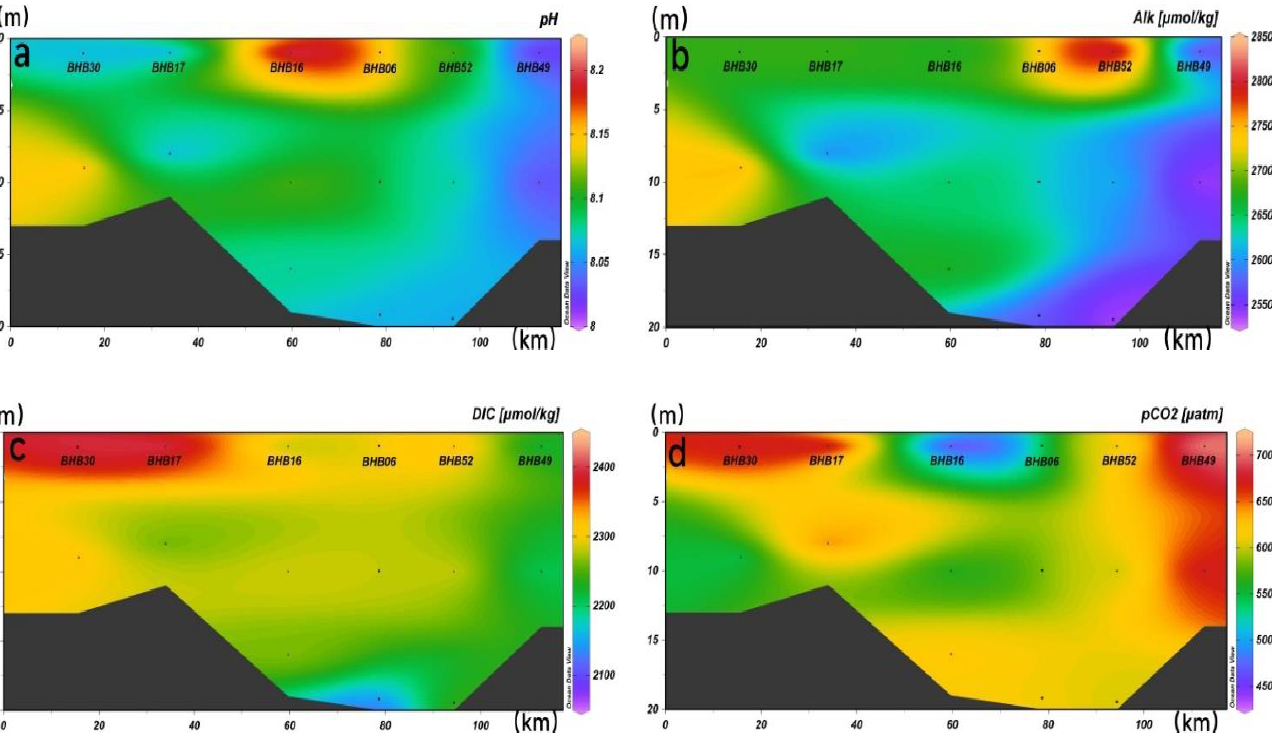
Figure 9. Vertical distributions of pH ( a ), Alk ( b ), DIC ( c ) and p CO 2 ( d ) in transect B of Bohai Bay in summer 2020. This image was created with ODV software, version 5.3.0 (Alfred Wegener Institute, Bremerhaven, Germany).